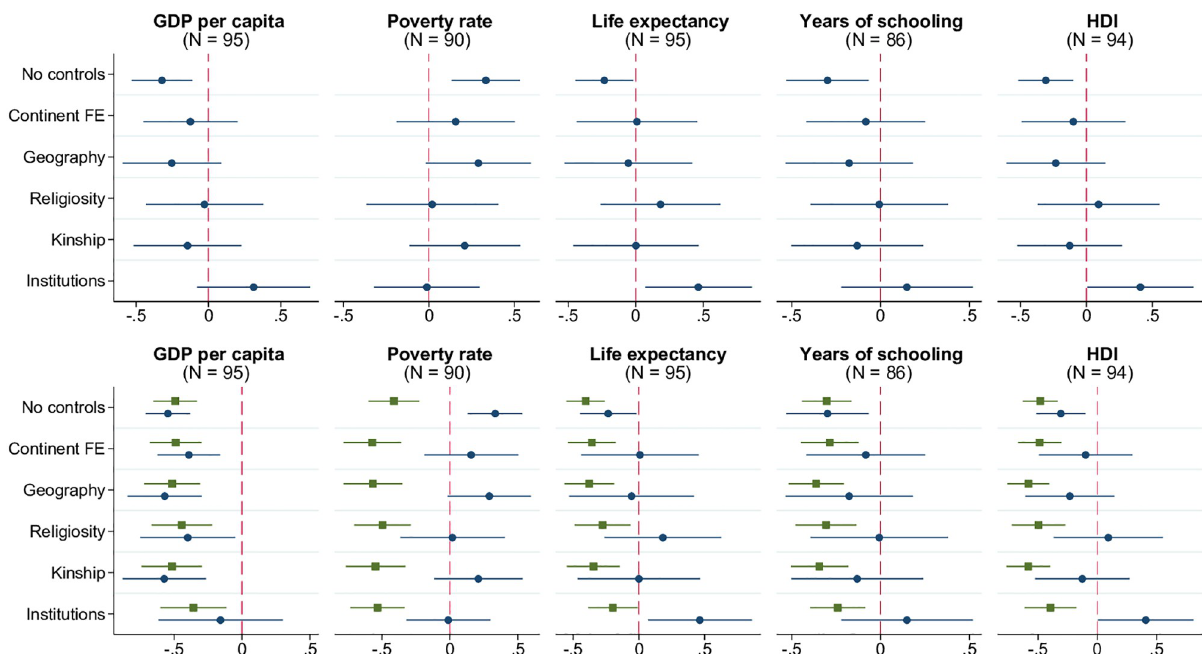
Fig 8. Witchcraft beliefs and development. Each panel in the top row of the figure presents the results of estimating 6 different models, in which the prevalence of witchcraft beliefs at the country level is regressed on the metric of development indicated in the panel title, along with a set of control variables. The latter is defined as follows according to the tickmarks on the vertical axis: 1) none for “No controls”, 2) only continental fixed effects for “Continent FE”, 3) continental fixed effects and baseline geographic controls (absolute latitude, terrain ruggedness, agricultural suitability of land, distance to the coastline) for “Geography.” The remaining 3 models, named “Religiosity,” “Kinship,” and “Institutions” include, respectively, average religiosity, kinship intensity index, and the rule-of-law index (in addition to continental fixed effects and geographic variables). The round marker represents the point estimate for the coefficient on the respective development indicator, and the linear segment around each marker is the corresponding 95% confidence interval based on heteroskedasticity-robust standard errors. Model specifications for the bottom row of the figure are identical, but the right-hand side of the regression equation includes both the linear and quadratic terms for development indicators. The square and round markers and associated confidence intervals in the bottom-row panels correspond to the coefficient estimates on the square and linear terms, respectively. Sample size N indicated in parentheses. The key variables are standardized to have zero mean and unit standard deviation in relevant samples.